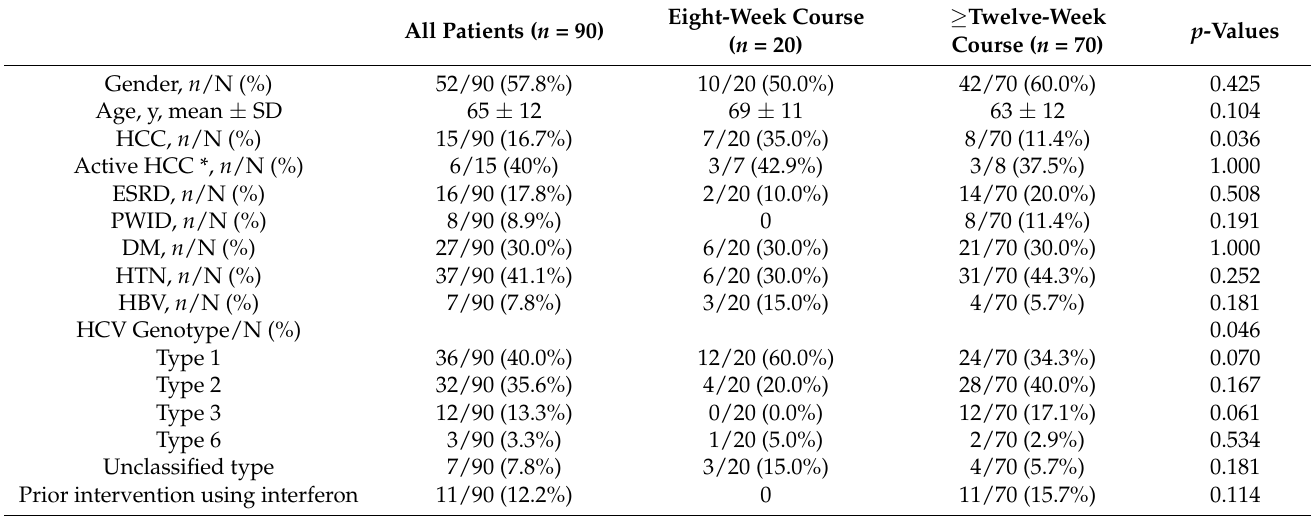
Table 1. Baseline characteristics of the study